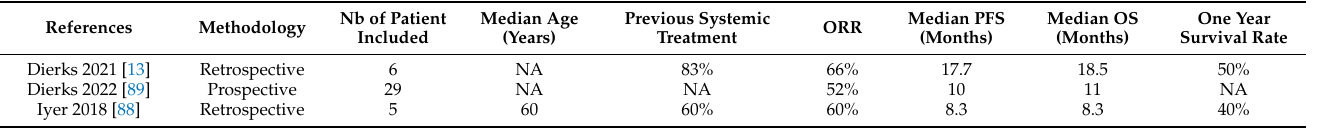
Table 3. Studies evaluating pembrolizumab and lenvatinib association in anaplastic thyroid cell carcinoma.